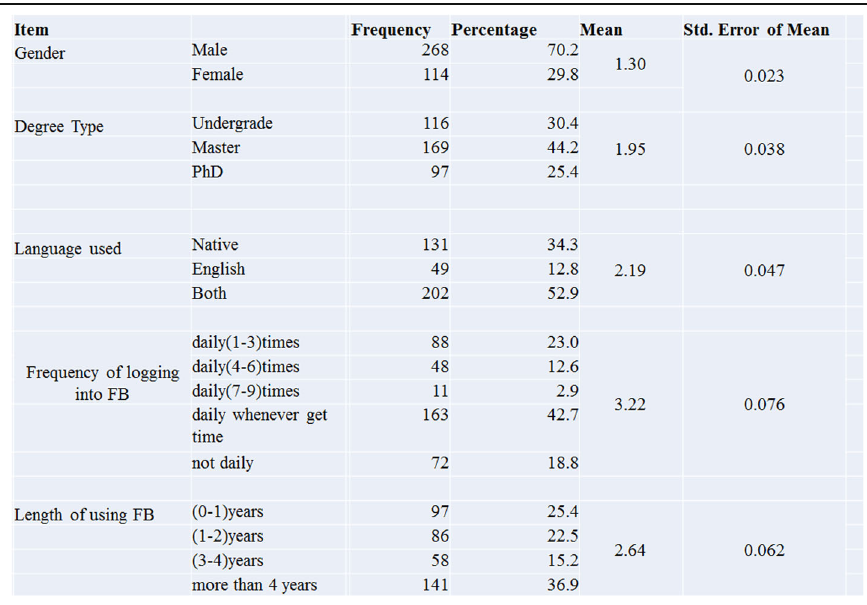
Table 1 Demographic profiles and descriptive statistics of the